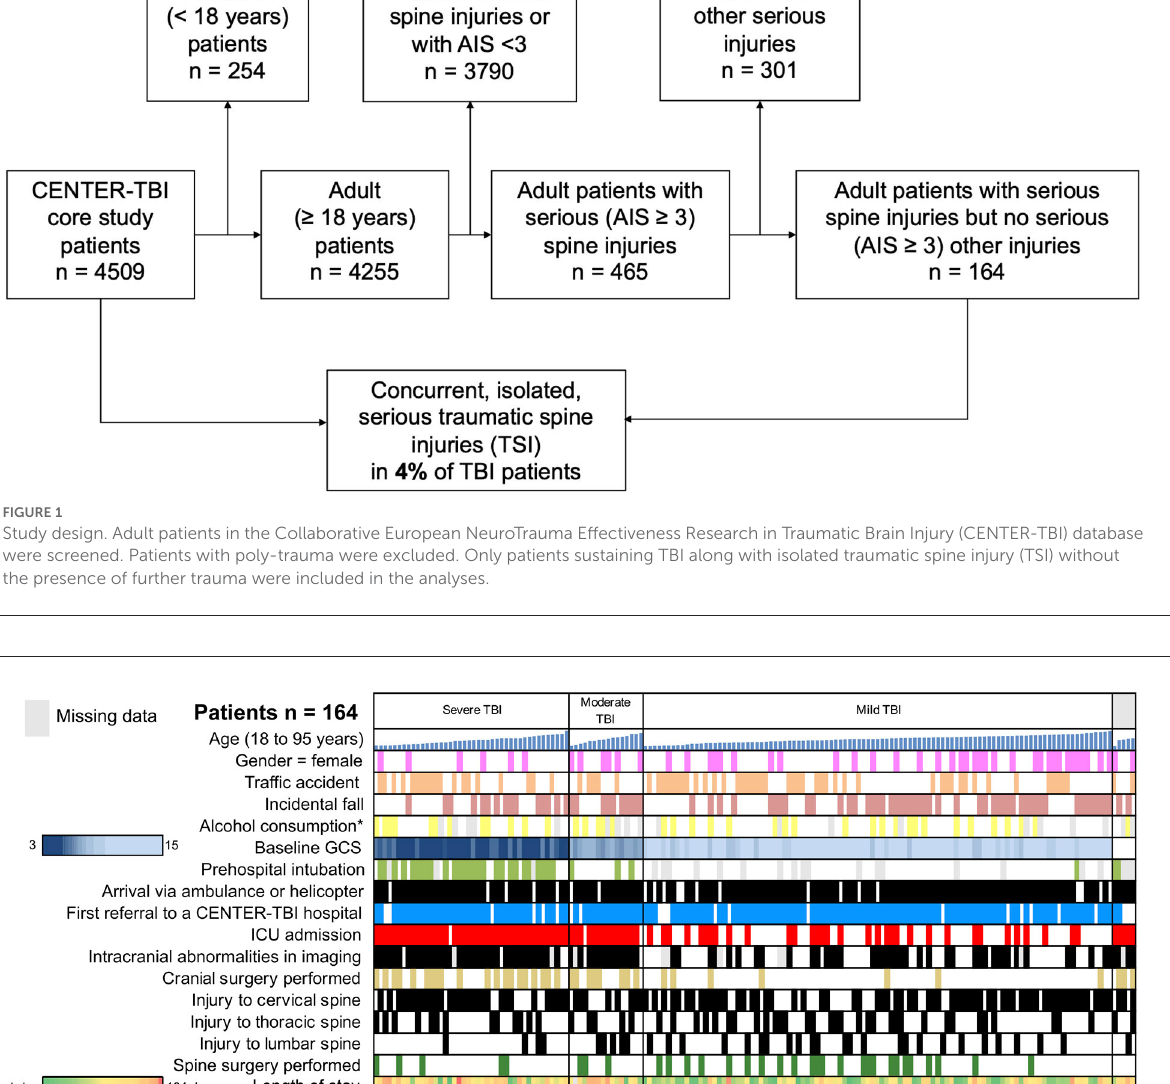
ASA class as covariables (see Supplementary Tables S2, S3 for balance statistics and exemplary descriptions of the